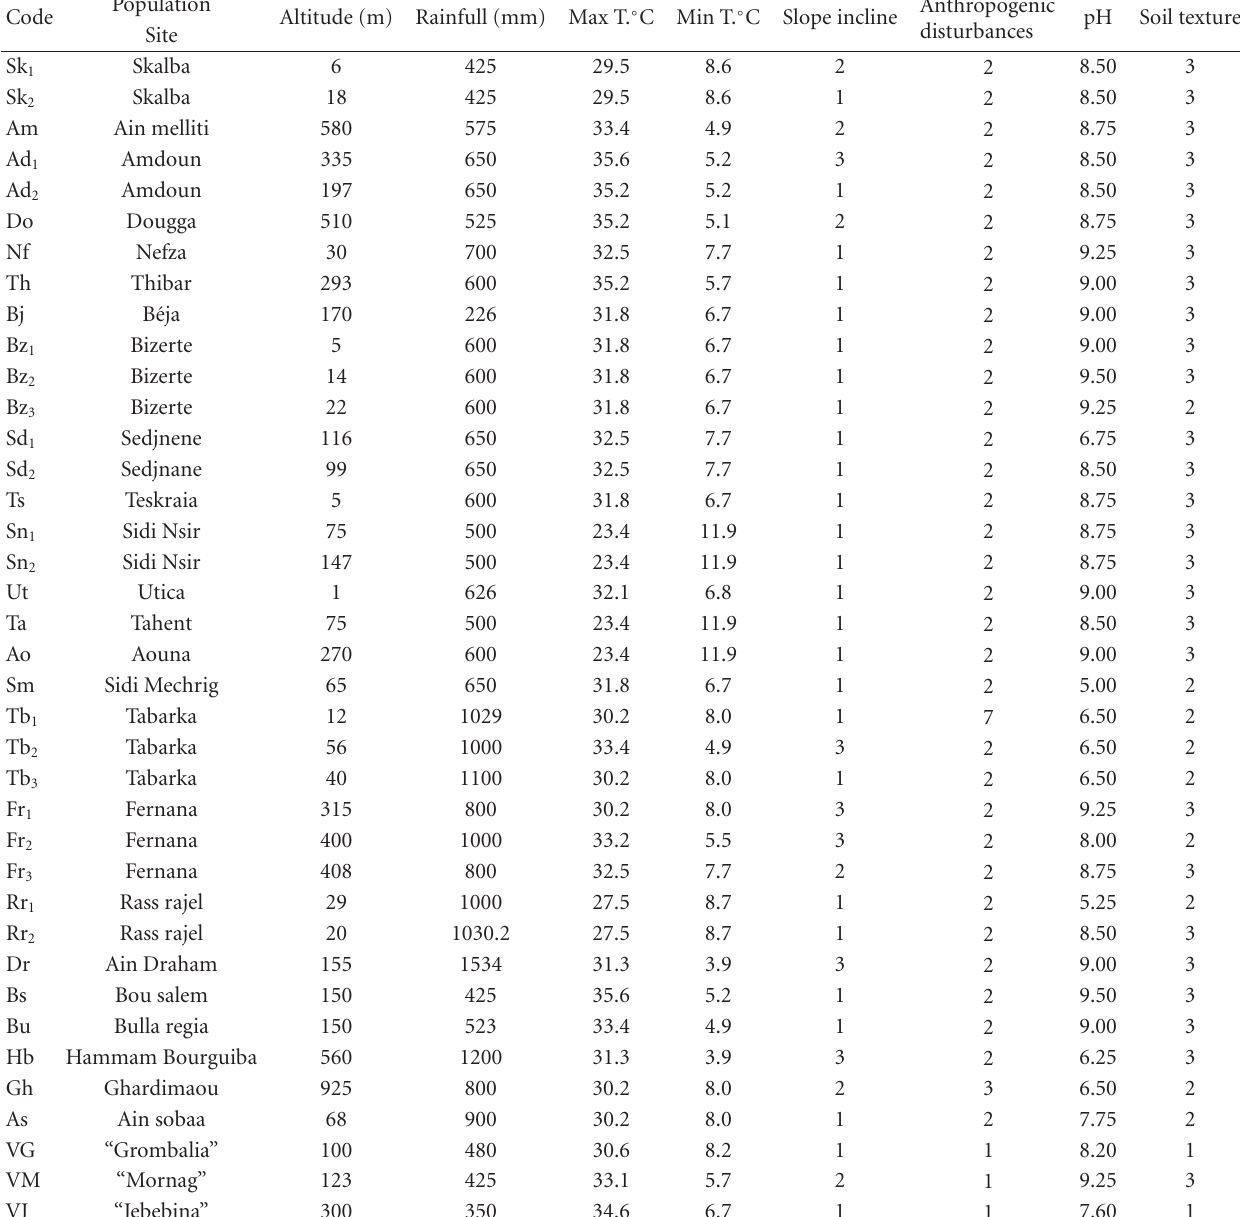
Table 1: Description of agroecological parameters at the collection sites of each accession.